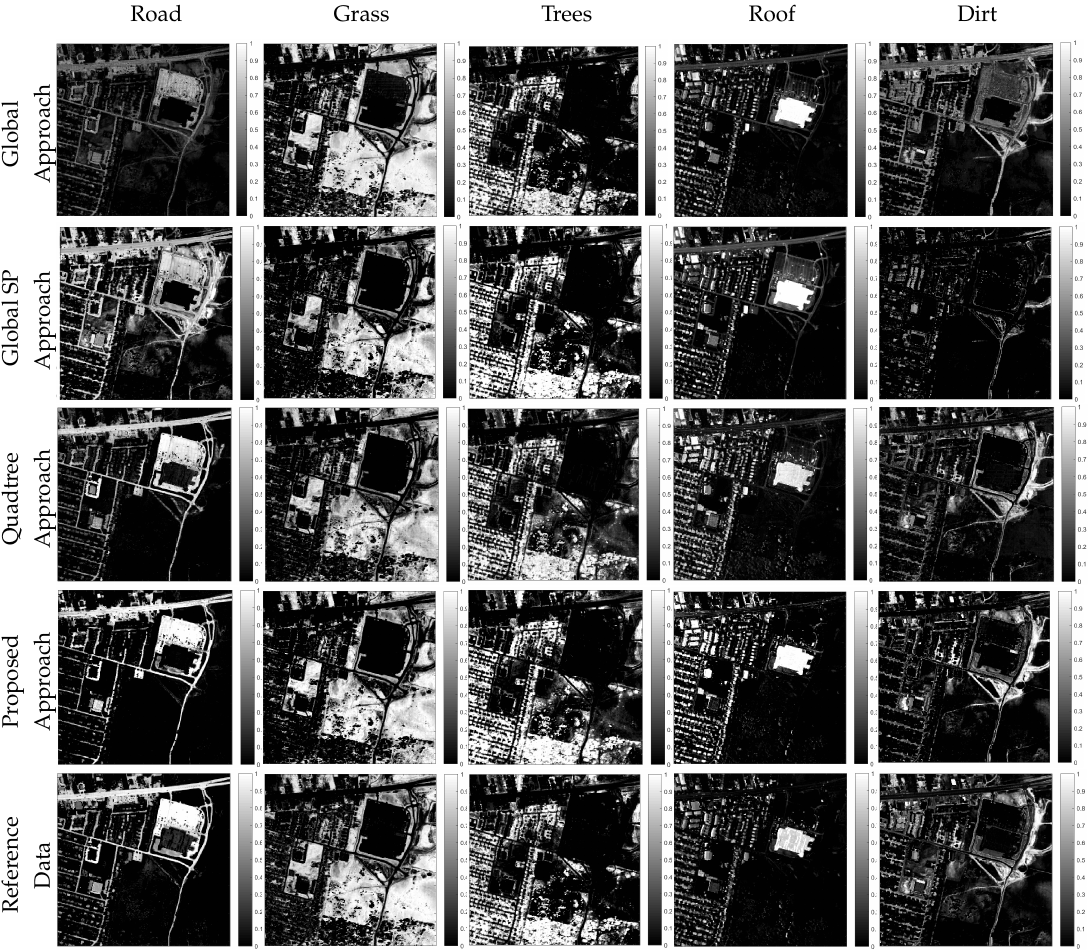
Figure 29. Comparison of abundance maps by different approaches with the proposed method and reference